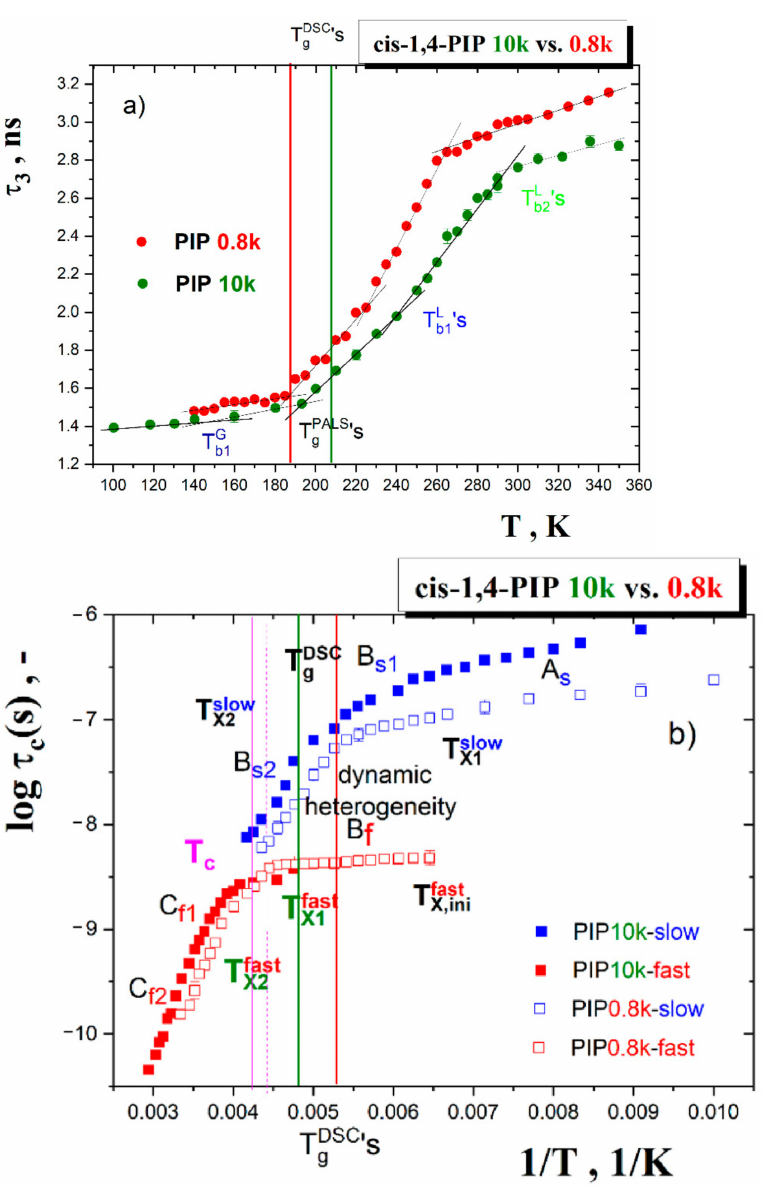
Figure 15. Comparison of the ESR and PALS data for cis -1,4-PIP10k vs. cis -1,4-PIP0.8k [39] in terms of ( a ) τ 3 vs. T and ( b ) log τ c vs.1/ T